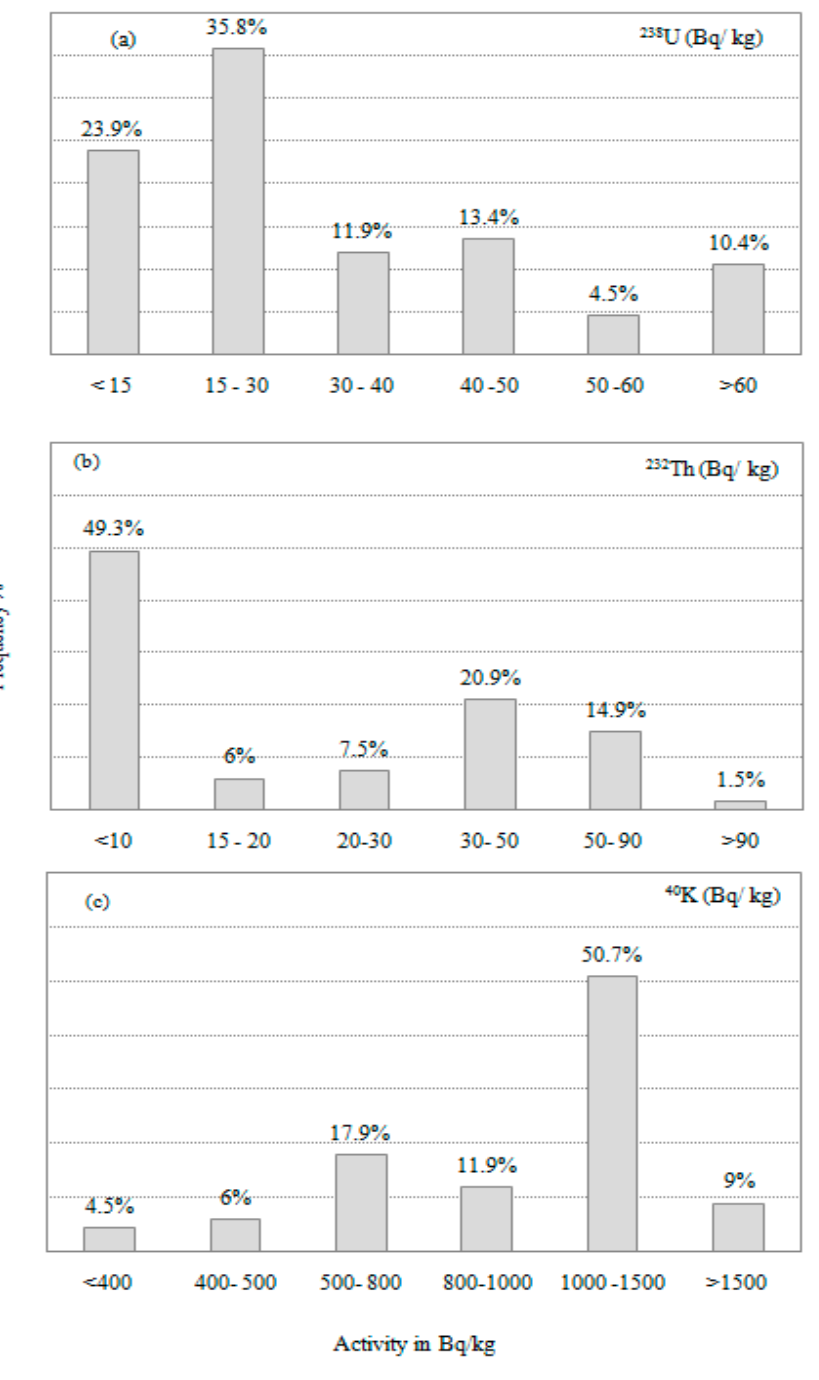
Figure 2. Frequency distributions of activity concentrations (Bq/kg) for pegmatite from Hafafit ( a ) 238U ( b ) 232Th and ( c ) 40K.